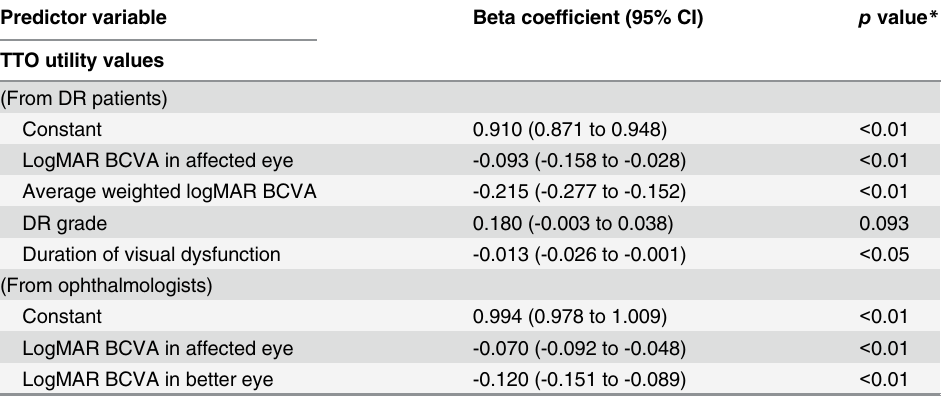
TTO, time trade-off; CI, con fi dence interval; BCVA, best-corrected visual acuity; DR, diabetic